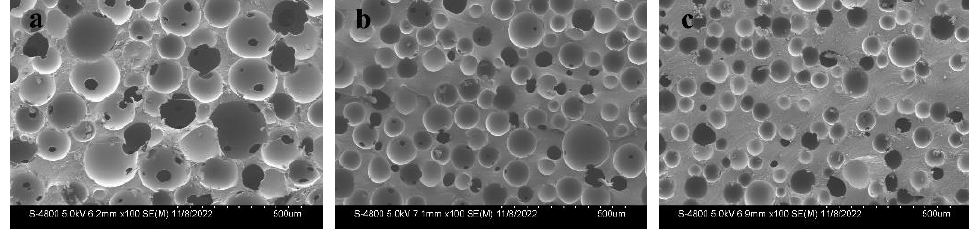
Figure 6. SEM microstructures of the PUMEs with densities of ( a ) 400 kg/m 3 , ( b ) 600 kg/m 3 and ( c ) 800 kg/m 3 at 23 °C ± 2 °C.